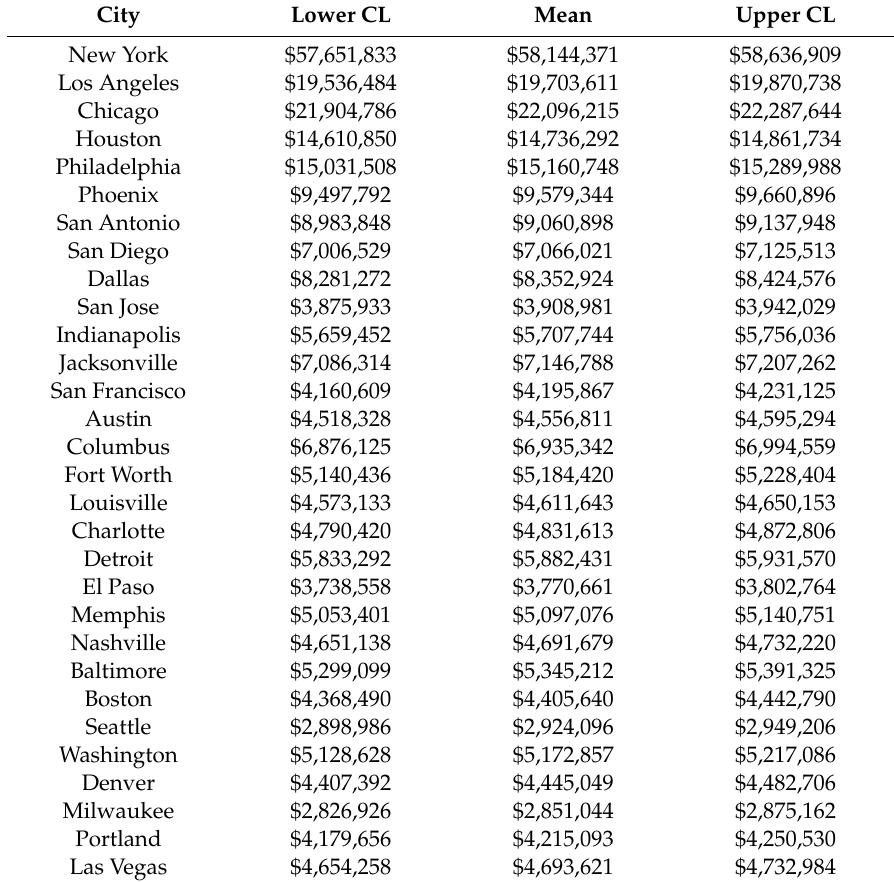
Table 3. Means and Confidence Intervals of Total Costs for All Cities based on Simulation Results. City Lower CL Mean Upper CL New York